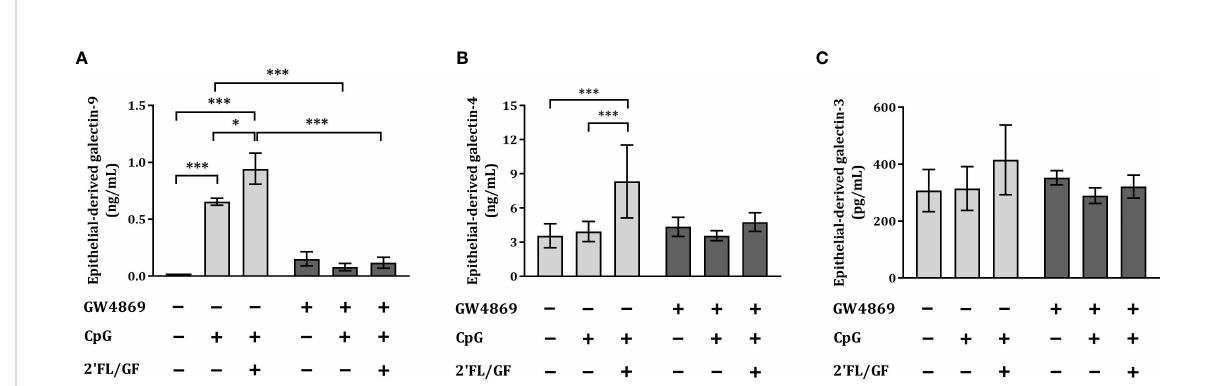
FIGURE 5 Exposure to GW4869 suppressed epithelial-derived galectin-4 and -9 secretion. IEC (HT-29 cell line) were apically exposed to 10 µM GW4869 for 1 hour after which 0.5% ( w/v ) 2 ’ FL/GF mixture and CpG were added. In the basolateral compartment a CD3/CD28-activated PBMC were added and incubated. After 24h incubation, IEC were separated from the PBMC fraction, washed and incubated in fresh medium or in the presence of 10 µM GW4869 for additional 24 h (total 48h; 24h IEC/PBMC co-culture and additional 24h IEC culture) after which the basolateral supernatant was collected and epithelial-derived galectin-9 (A) , -4 (B) and -3 (C) were measured. Data are represented as mean ± SEM of n = 6 (A, B) or n = 4 (C) independent PBMC donors (*p < 0.05, ***p <